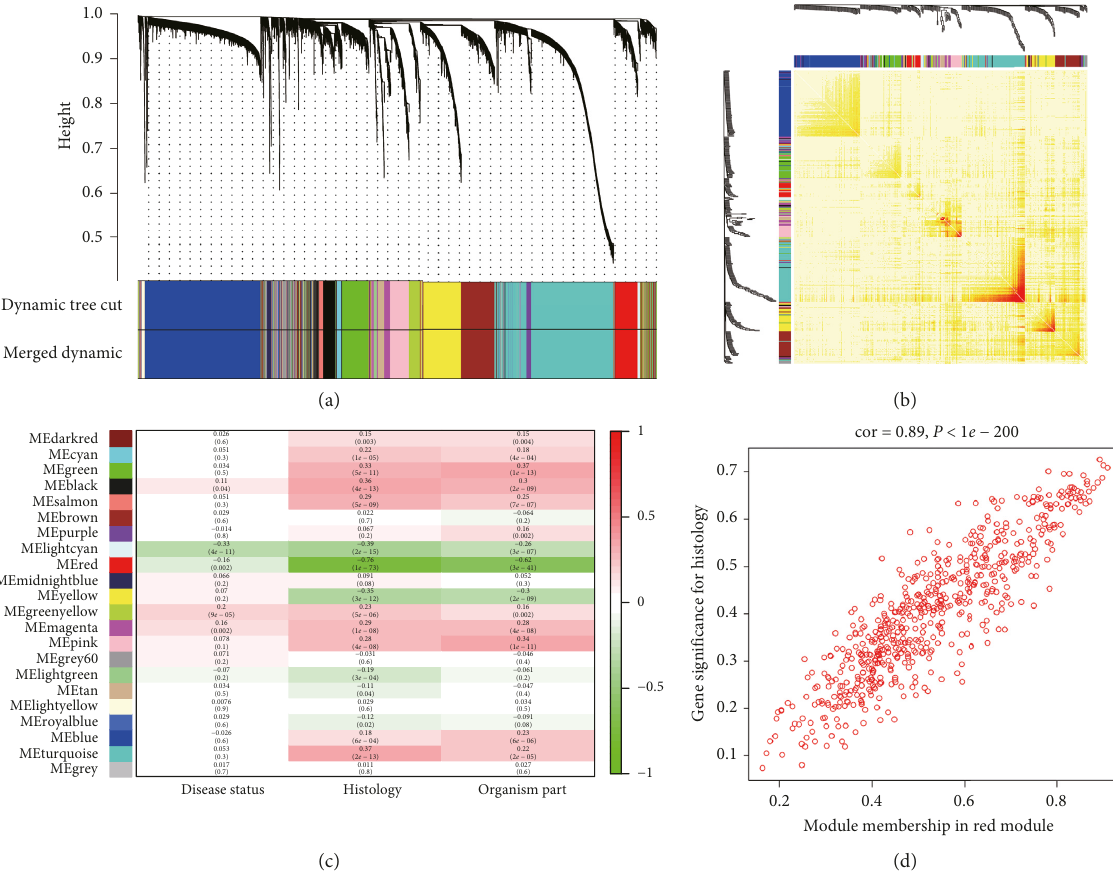
Figure 1: Modules defined by the WGCNA. (a) Dendrogram tree represents the clustering dendrogram of genes in GSE68468, and the bottom colorful bands represent 22 modules assigned by genes. (b) A network heatmap plot of 400 genes. The intensity of the red color indicates the strength of the correlation between pairs of modules on a linear scale. (c) Correlation between modules and clinico- pathologic features. The correlation coefficient and corresponding P value of each module are shown in each cell. (d) Correlation (Pearson) between module membership and gene significance for the red